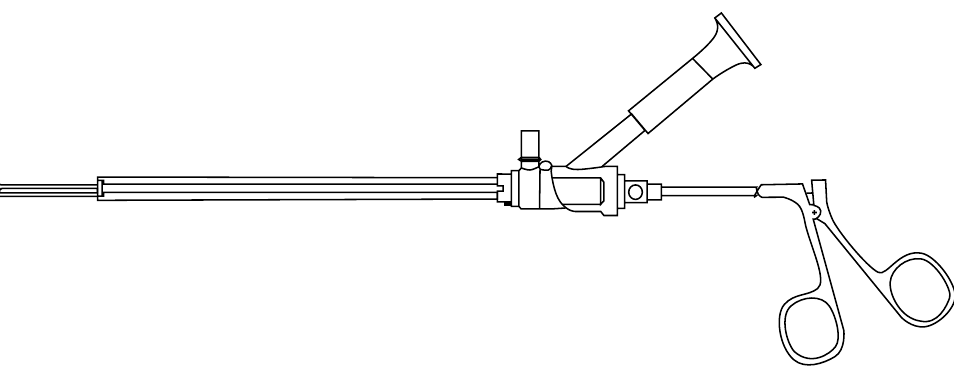
Figure 1. A nephroscope: this tool is inserted into a patient’s back during a PCNL procedure. The eyepiece on the top of the nephroscope enables the surgeon to see inside the kidney. Tools are used through the nephroscope to breakup and remove kidney